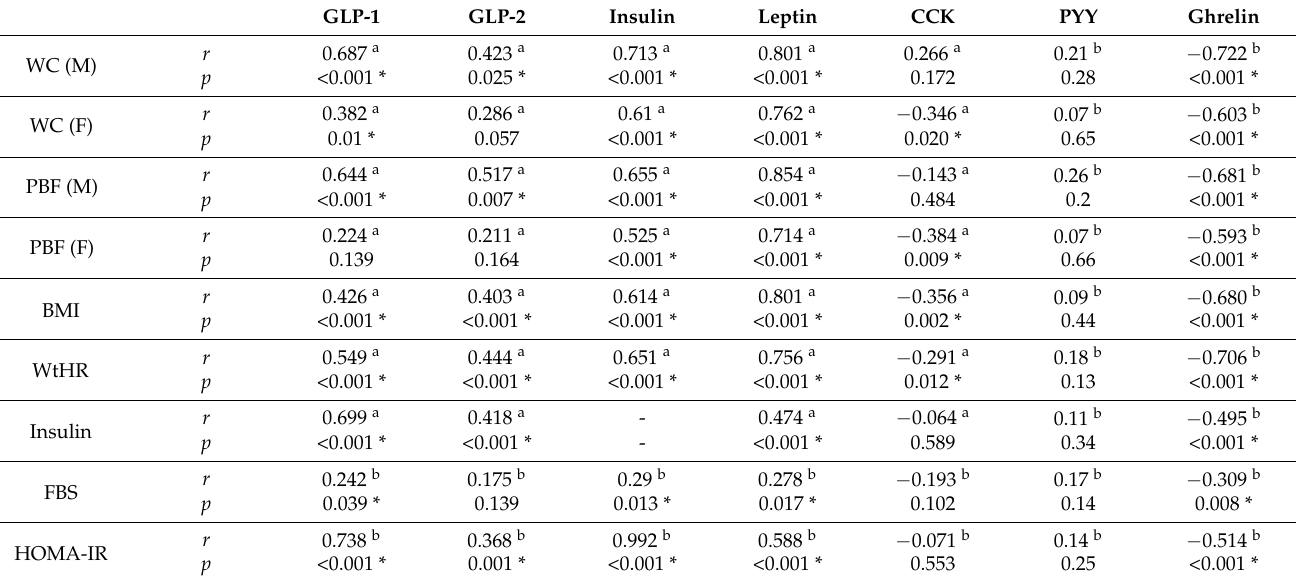
Table 2. Correlations between peptide hormones and markers of obesity and IR.